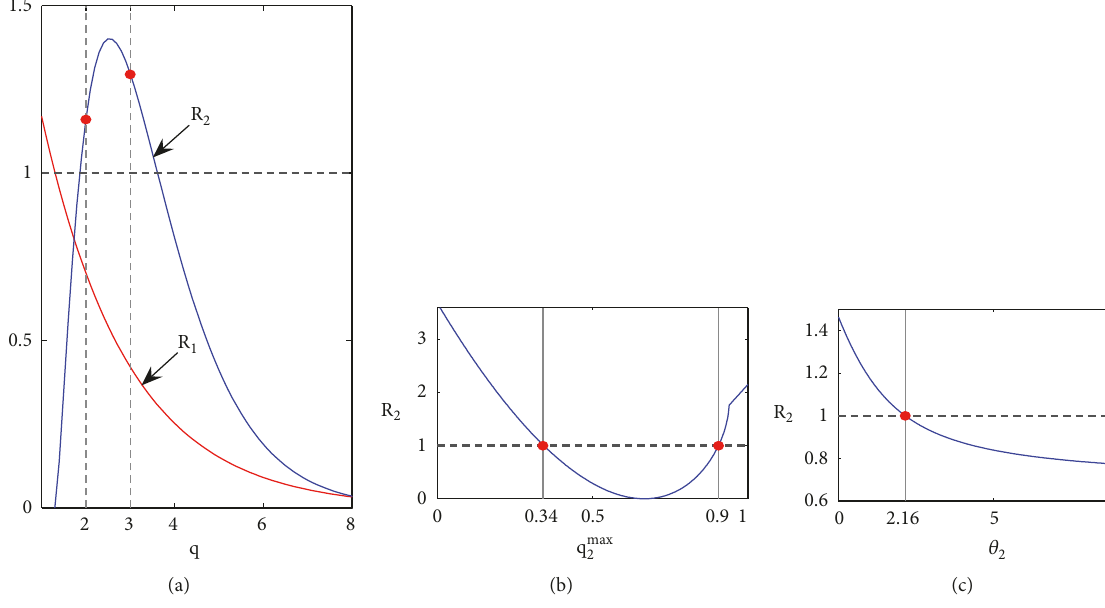
Figure 1: Sensitivity analysis for R 1 , R 2 . (a) The curves of R 1 - 𝑞 and R 2 - 𝑞 , parameters are 𝑟 = 0.5 , 𝑎 = 0.01 , 𝑞 𝑚𝑎𝑥 2 = 0.95 , 𝜎 = 0.6 , 𝜃 2 = 0.2 , 𝑞 𝑚𝑎𝑥 𝑟 = 0.4 , 𝑎 = 0.05 , 𝑞 𝑚𝑎𝑥 𝜏 = 0.2 ; (b) the curve of R 2 - 2 with 𝑎 = 0.05 , 𝑞 𝑚𝑎𝑥 = 0.3 , 𝜎 = 0.8 , 𝜏 = 1.2 , 𝑞 = 2 2